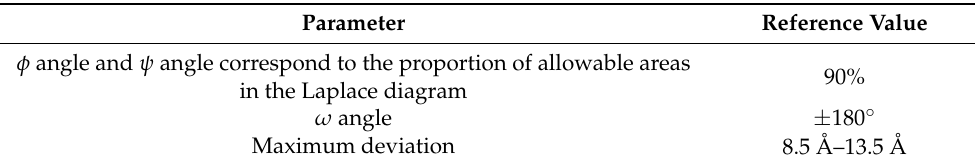
Table 3. Structure evaluation parameters of SAVES.